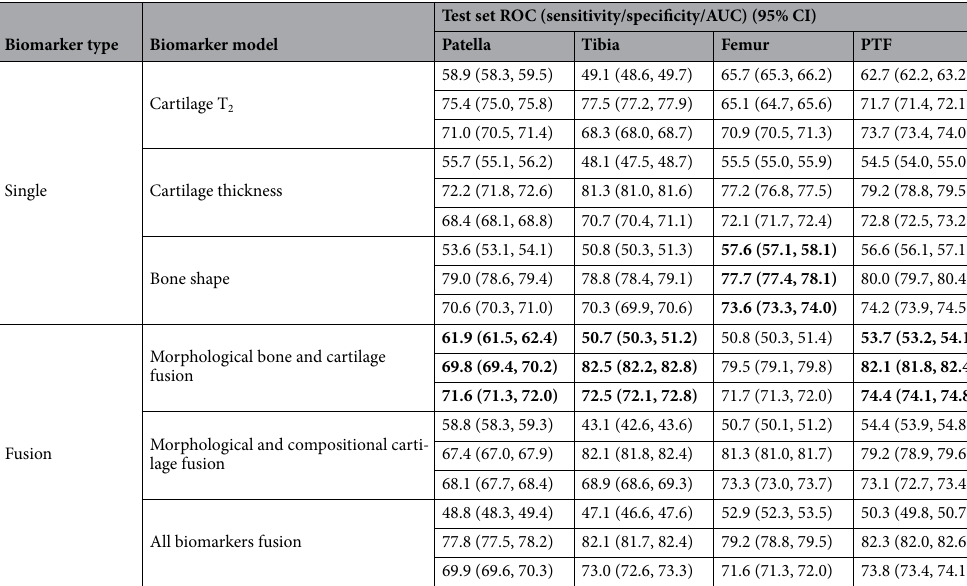
Table 1. Bootstrapped (n = 100) test set chronic pain ROC performance for all six biomarker models per bone, as well as an average ensemble across all bones. Sensitivity, specificity, and AUC values are shown respectively, along with their corresponding 95% confidence intervals. The best performances per bone and ensemble are bolded. PTF = Patella + Tibia + Femur ensemble. Result metrics are for the first timepoint for each patient.